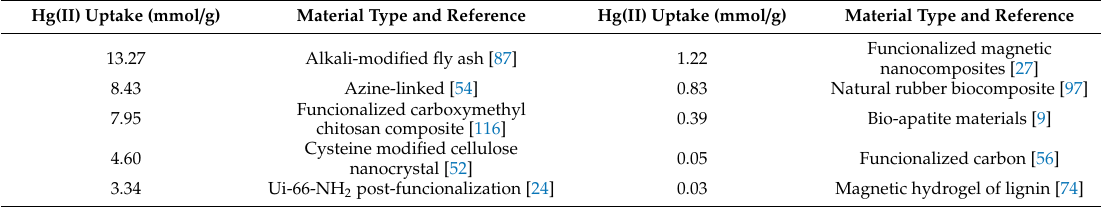
Table 7. Selected Hg(II)